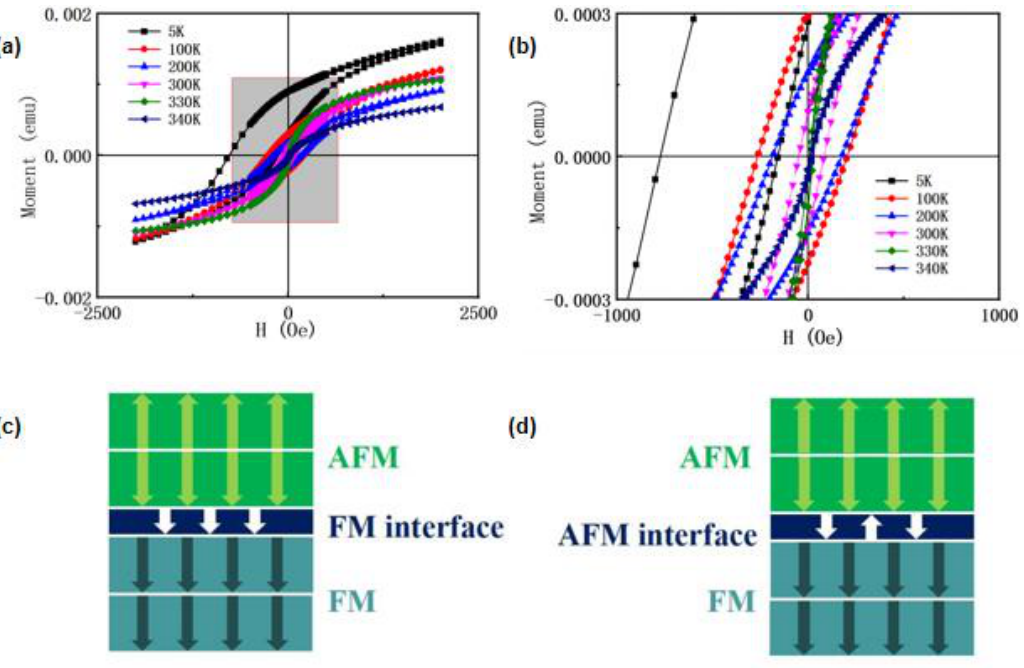
8 of 10 Figure 5. The M-T curves with ZFC, FC, and FW measurement for the Ni-Co-Mn-In alloy films. ( a ) #1, ( b ) #2, ( c ) #3, ( d ) #4. The EB effect of the Ni-Co-Mn-In alloy film (#3) with prominent and well-defined